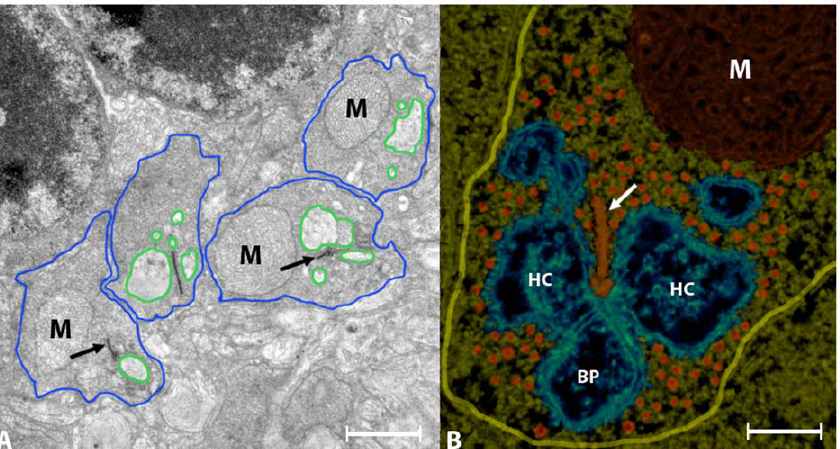
Figure 1. Rod photoreceptor axons of mouse retina. Panel A shows cross-sections of four rod spherules (blue lines). The principal organelles in the cytoplasm are electron-dense structure representing the synaptic ribbon (arrows), the mitochondria (M), and invaginations containing the endings of horizontal and bipolar cell processes (green lines). Synaptic vesicles are not resolved clearly at this magnification. Panel B shows a reconstructed ribbon synapse. The ribbon appears as a pole that is sandwiched between the endings of horizontal cell (HC) endings at each side and the bipolar cell (BP) dendrite is below the ribbon. The arciform density appears as a separate particle that links the base of the ribbon to the plasma membrane. Synaptic vesicles appear as spheres (orange) in the cytoplasm. The yellow line outlines the boundary of the axon terminal. Bars: A=1.5 m m, B=0.15 m m.